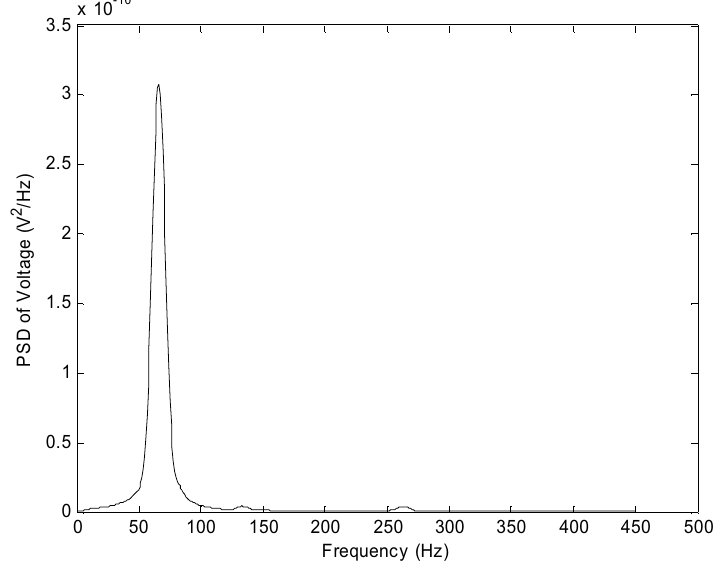
Fig. 18. Frequency spectrum of the PZT sensor voltage of Fig. 17.